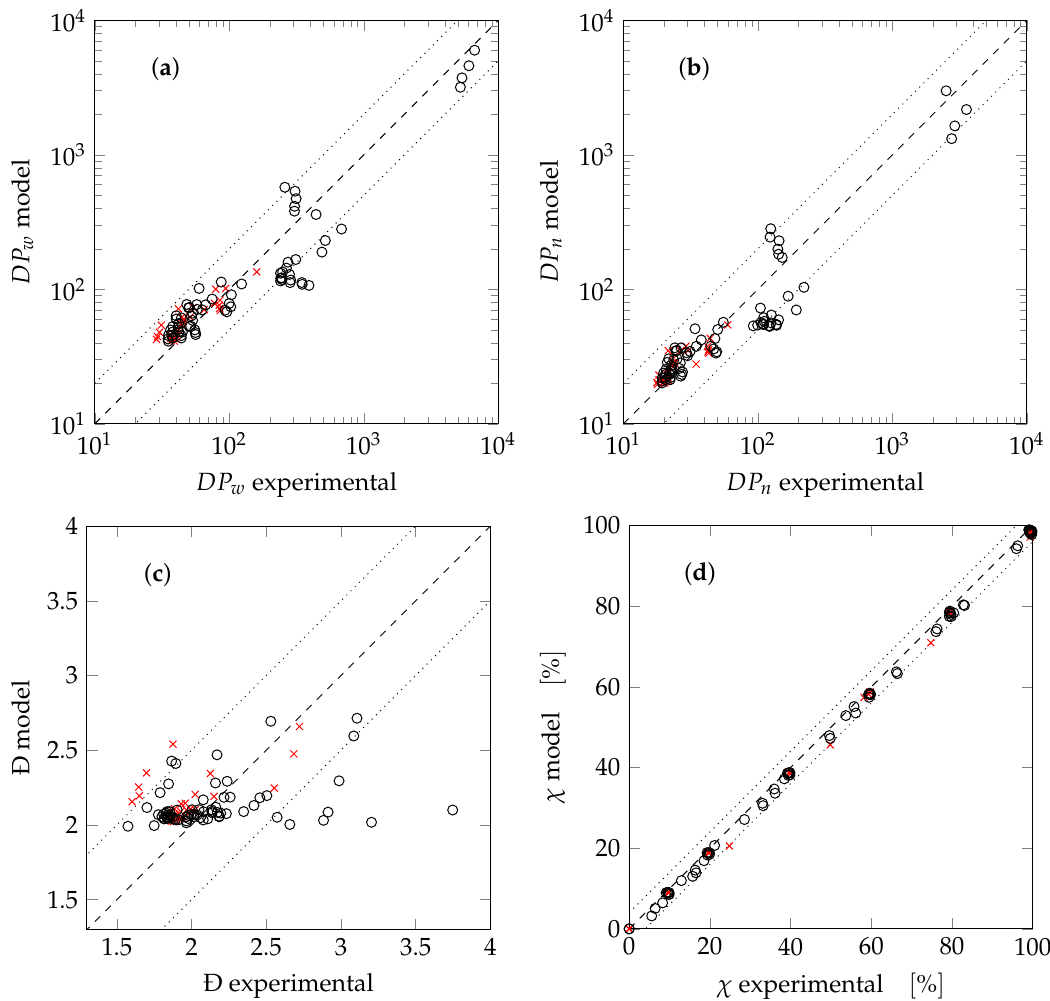
Figure 8. Parity plots for the SBR tests: ( a ) weight-average chain length; ( b ) number-average chain length; ( c ) polydispersity; ( d ) overall conversion. Crosses indicate data used for the fitting